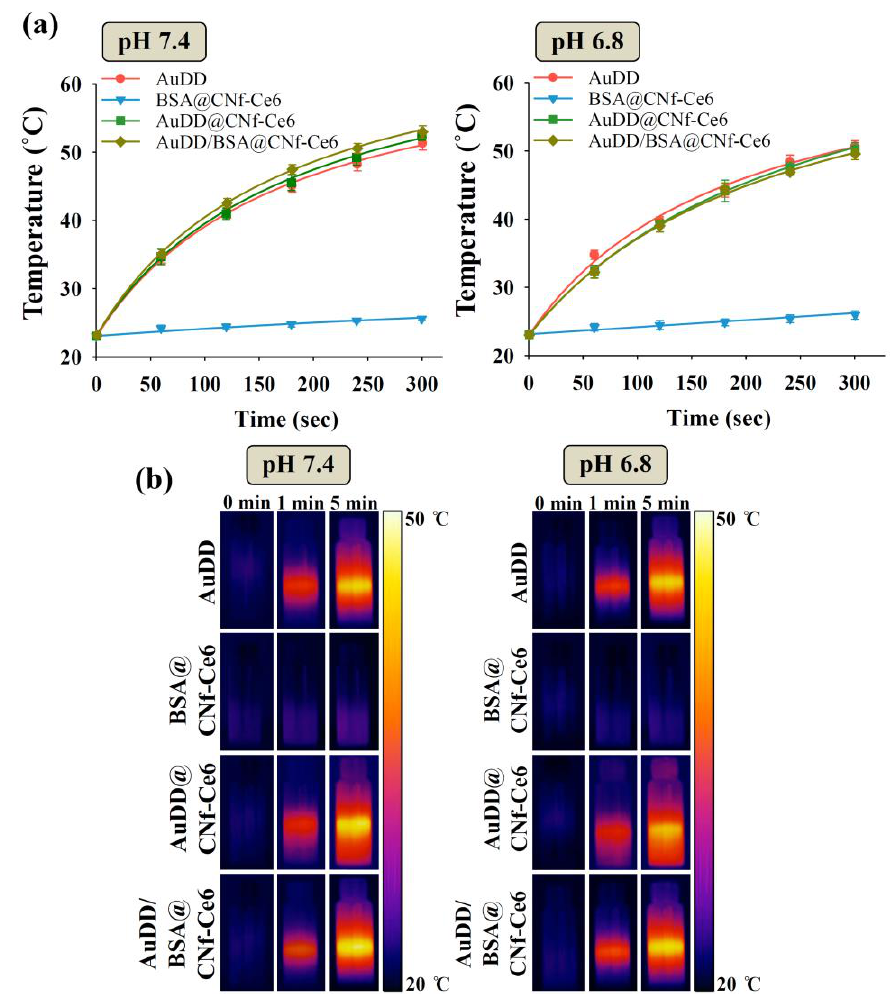
Figure 4. ( a ) Kinetic temperature changes and ( b ) photothermal images of each sample in PBS (150 mM, pH 7.4 and 6.8) irradiated at a light intensity of 2 W/cm 2 using an 808 nm light source for 5 min (mean ± SD, n = 3).